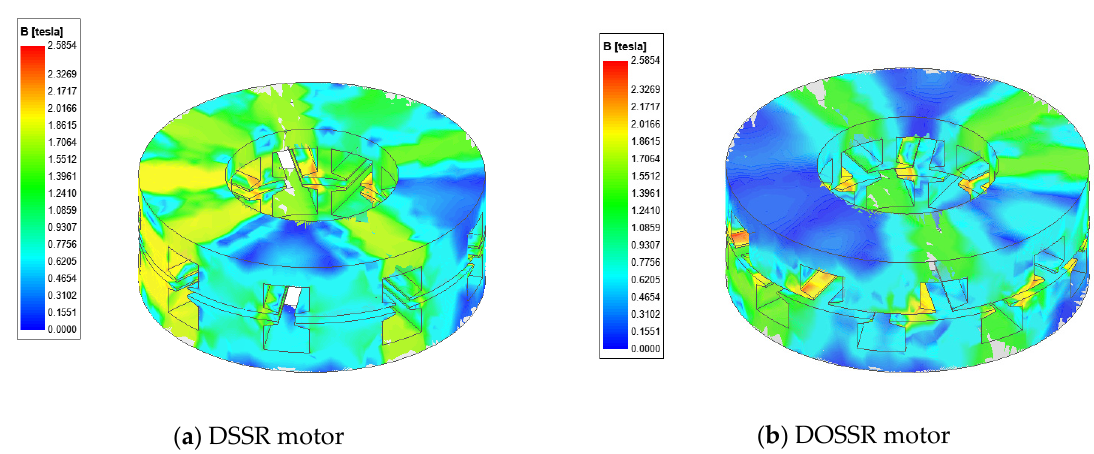
Figure 10. Flux density distribution for the DSSR motor and the DOSSR motor (100 A rms, 900 rpm).